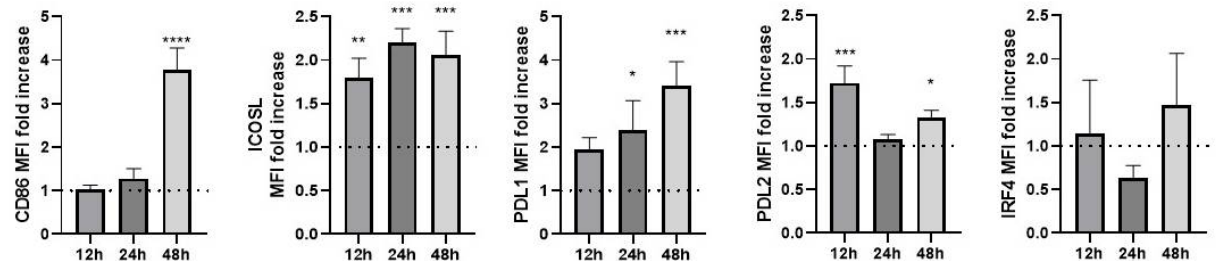
Figure 2. Fold increase in costimulatory molecules. The fold increase in costimulatory molecules and IRF4 MFI was calculated by dividing the averaged MFI obtained under the different concentrations of LPS stimuli by the MFI found in unstimulated Mo-DCs. The data shown represent the mean ± SD for 3 independent assays performed in triplicate. The dotted line represents basal expression. * p < 0.05, ** p <0.005, *** p < 0.0005, **** p < 0.0001.